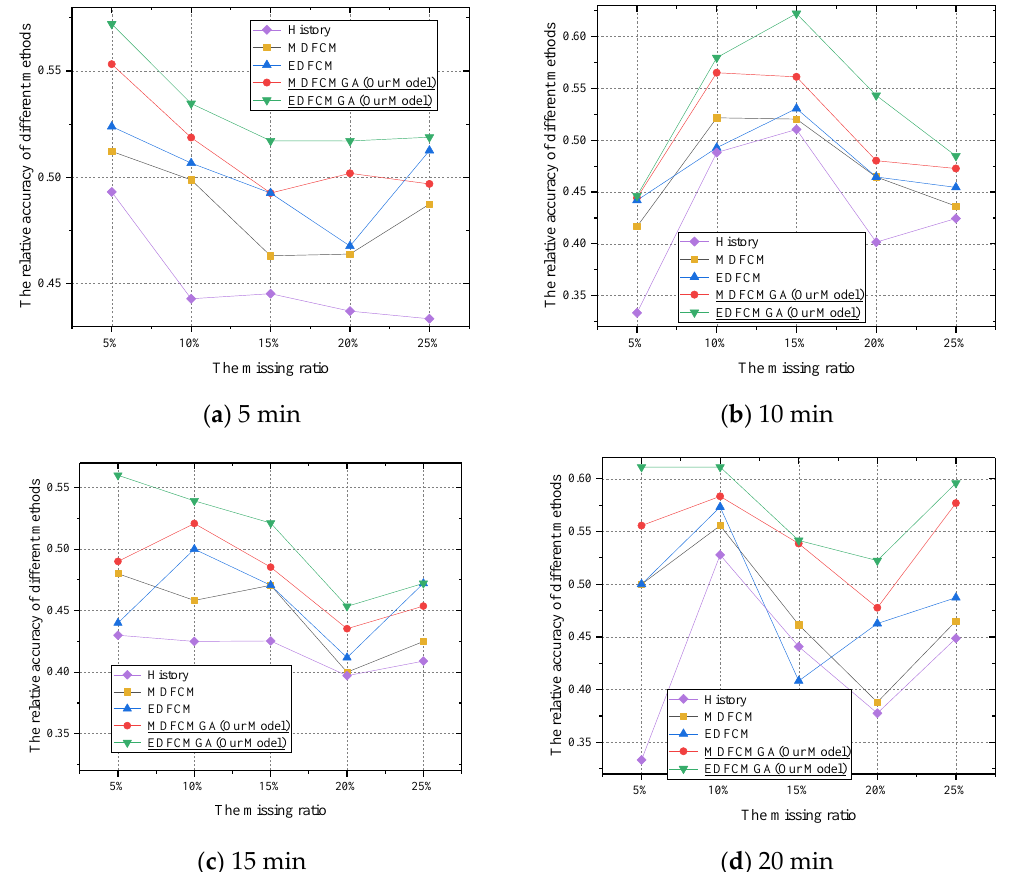
Figure 8. Relative accuracy (RA) comparisons under the condition of different data aggregation intervals, different missing ratios, and the ±5% tolerance error range.